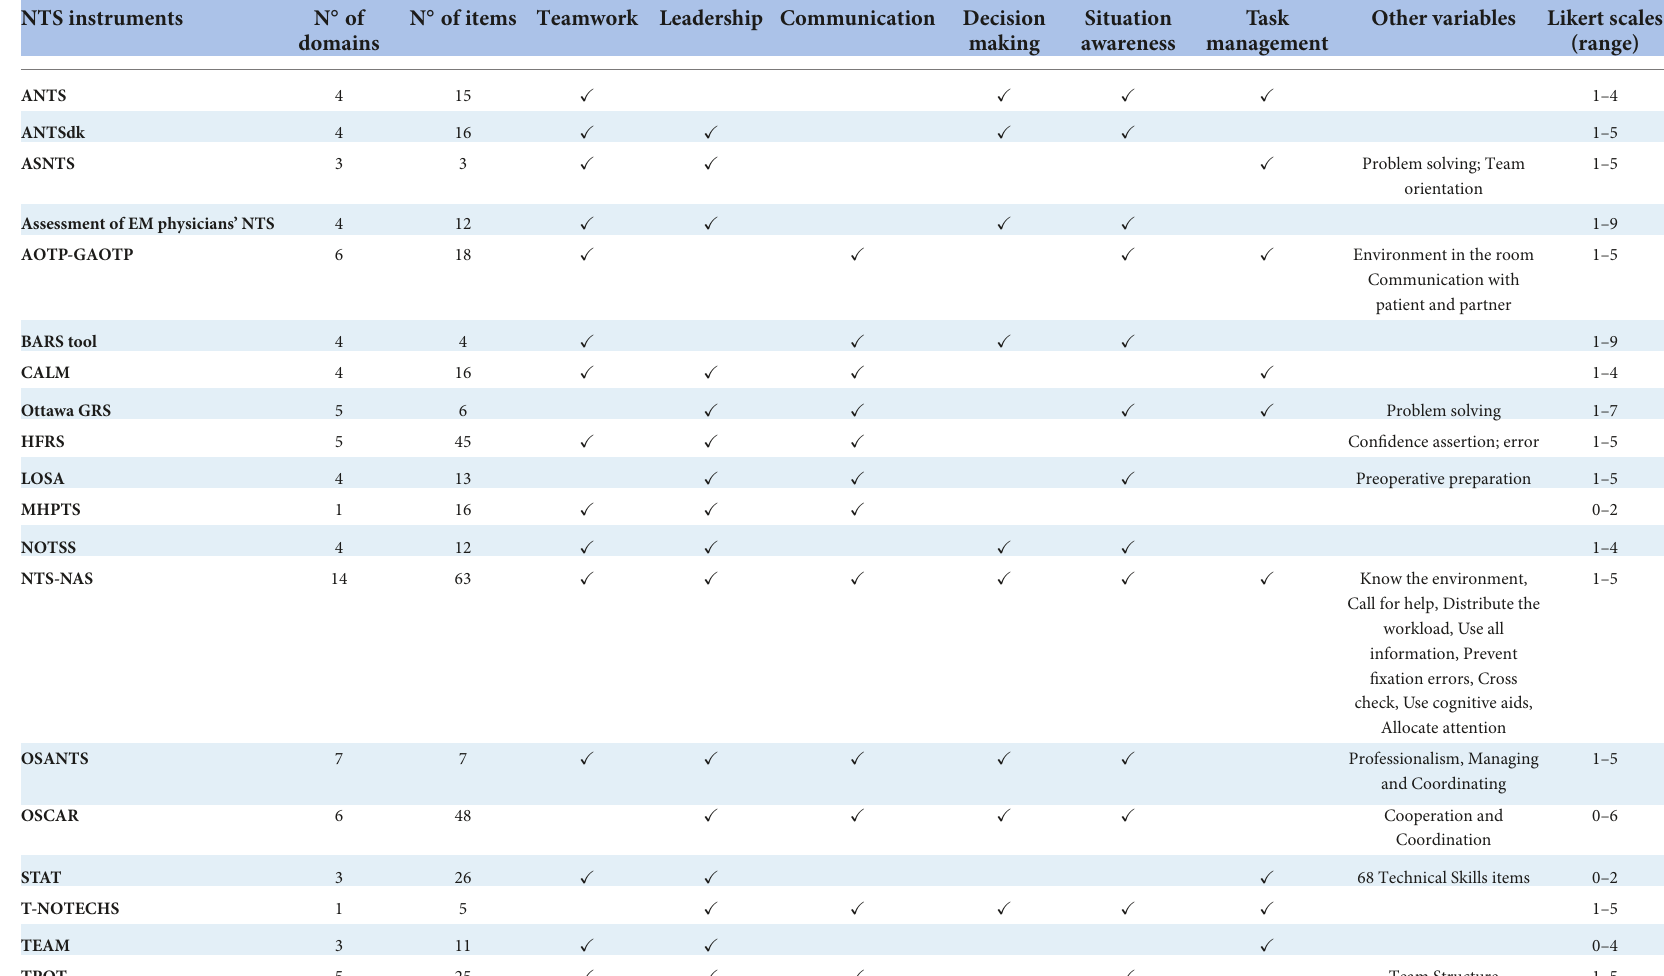
TABLE 1 Characteristics of the included non-technical skills